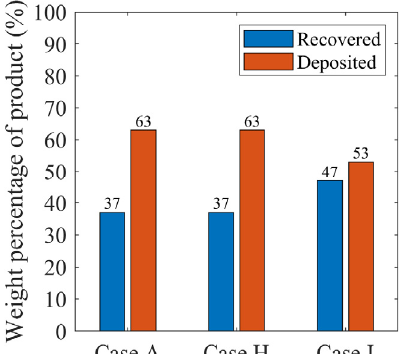
Figure 17. Gas moisture fraction profiles along the radial length of dryer at different distances from the atomizer for centerline of X–Y plane, (where atomizer location is z = 0 cm).